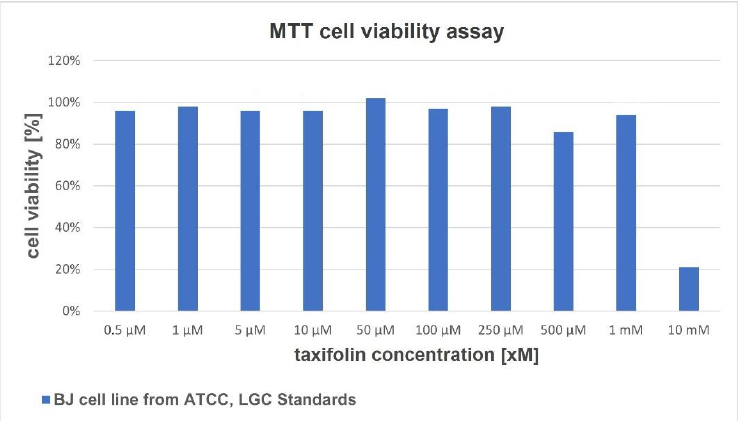
Figure 2. The MTT cell viability assay on a human skin fibroblast cell line. The results are expressed as cell viability in different taxifolin concentrations.